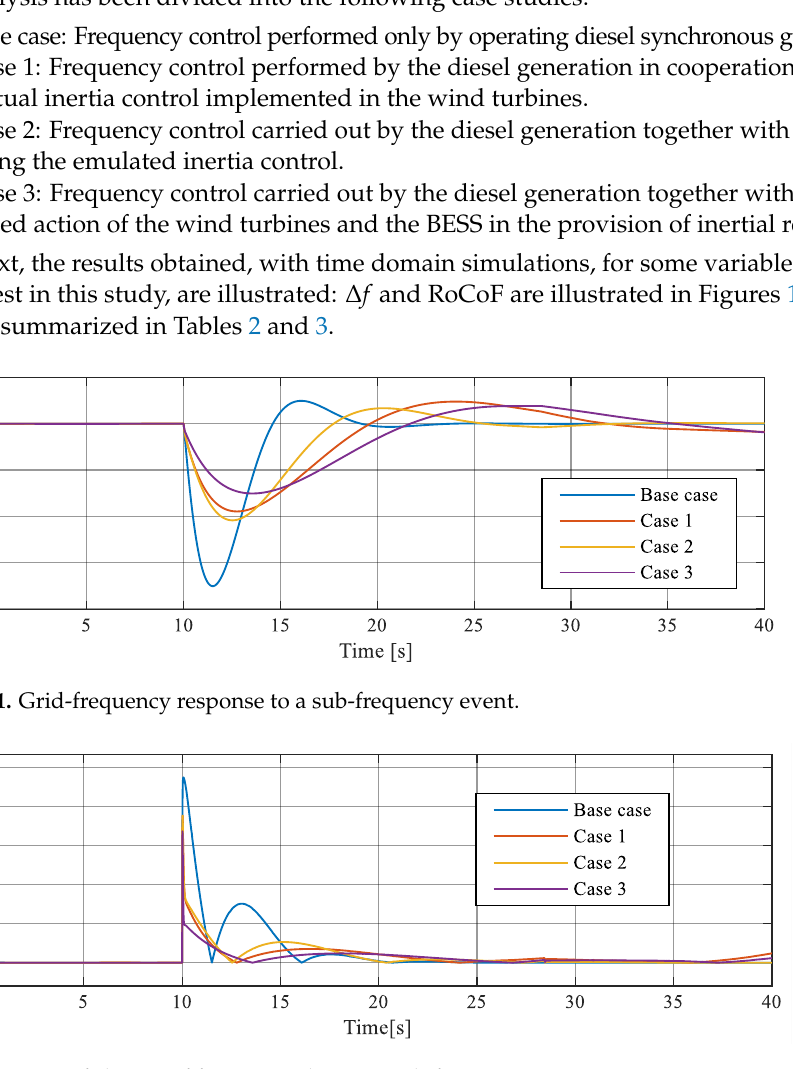
Figure 12. Rate of change of frequency during a sub-frequency event. Table 2. Reduction (%) of the frequency deviation compared to the base